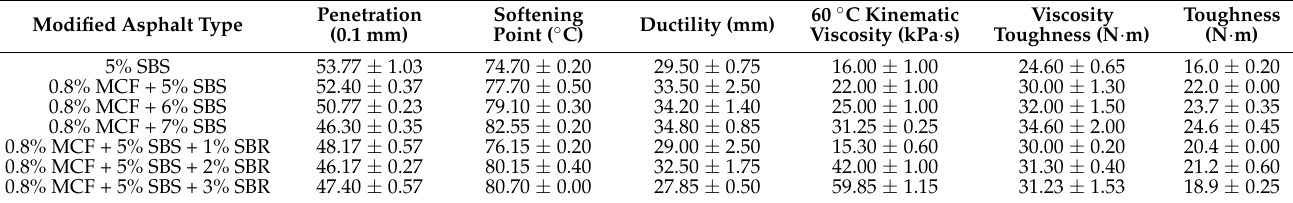
Table 7. Test results of asphalt technical